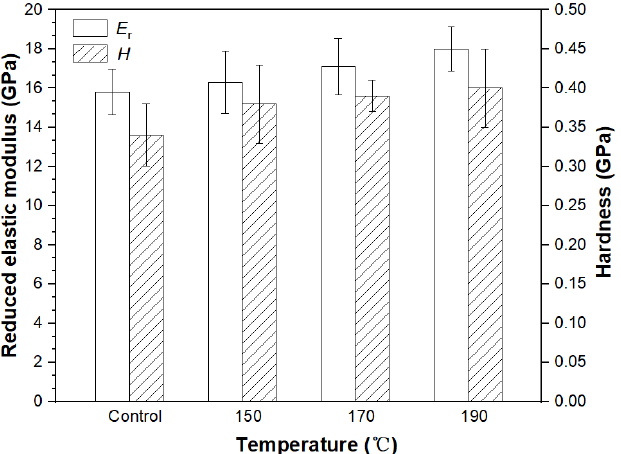
Figure 7. E ff ects of thermal modification on the E r and H of the cell Figure 7. Effects of thermal modification on the E r and H of the cell wall.